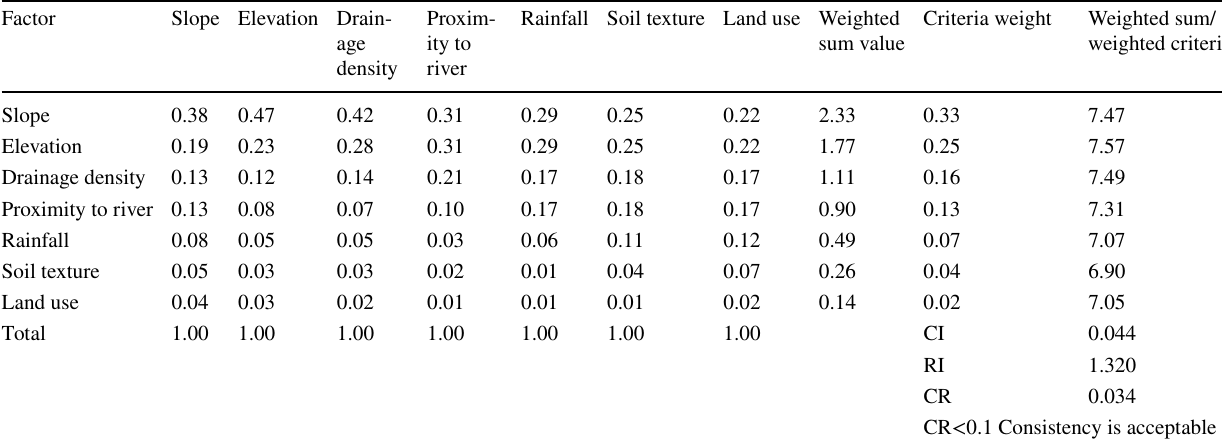
Table 8 Determined consistency ratios (CR) Factor Slope Elevation Drain-